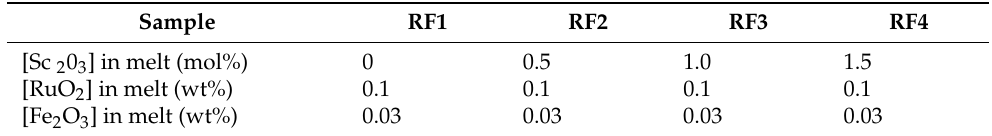
Table 1. The doping concentration of Ru:Fe:LiNbO 3 crystal.